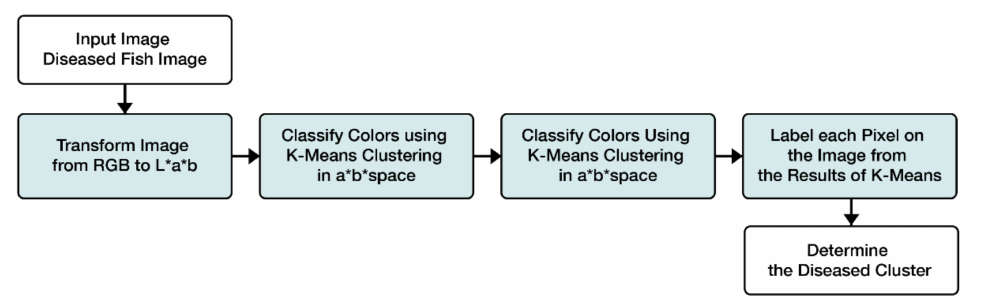
Figure 19. Complete process of Principal Component Analysis (PCA).